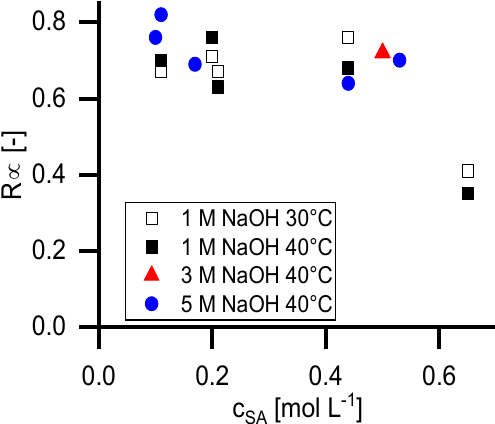
Figure 5. Retention of succinic acid at infinite permeate flux ( R ∞ ) in dependency of feed concentration calculated with the Pusch model. NaOH concentration and temperature are shown as process parameters for the generated data.